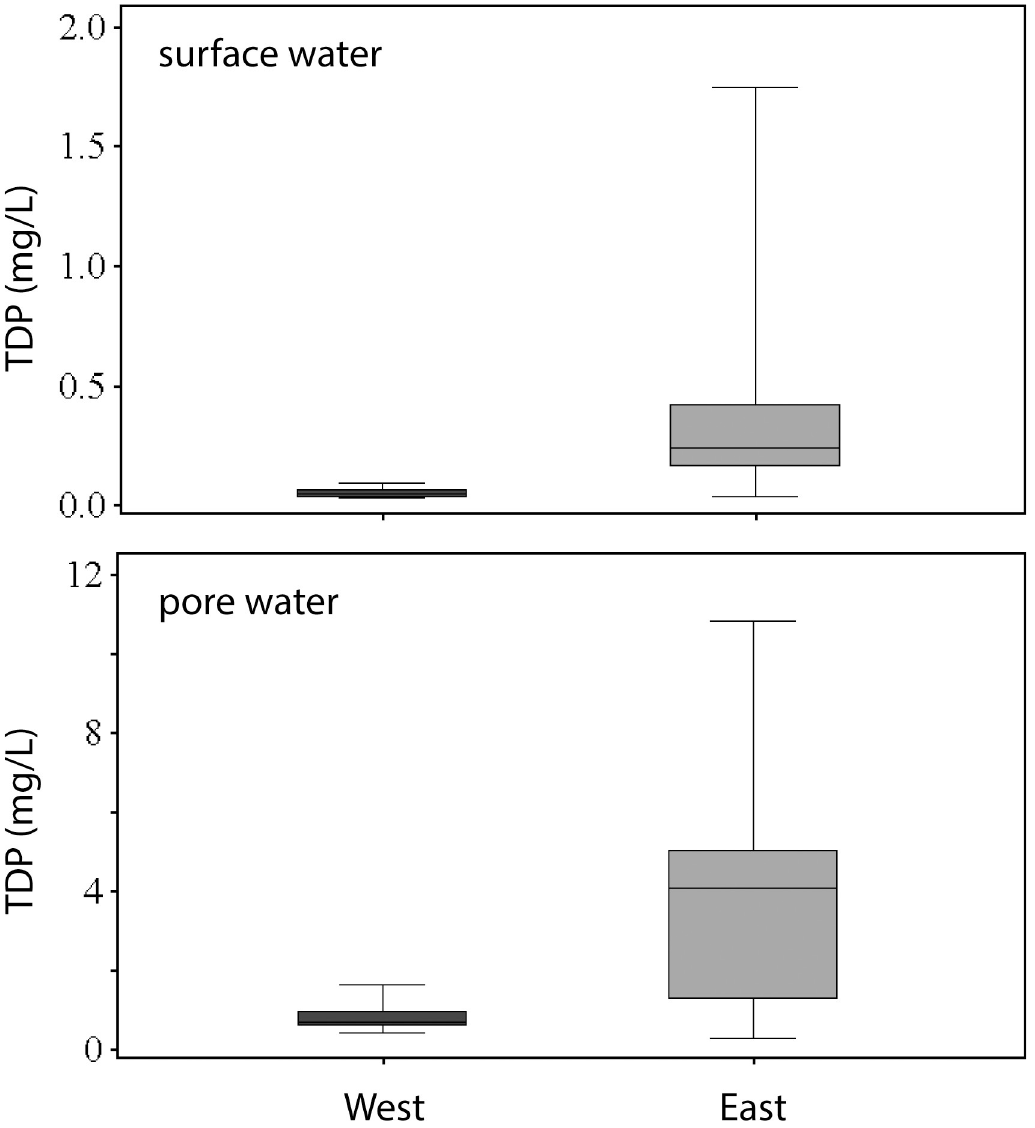
Fig 5. Total dissolved phosphorus (TDP) concentrations in surface water (top) and pore water (bottom). West samples ( n = 13) were collected from sites 2–3, 5–10, and 14. East samples ( n = 13) were collected from sites 1, 4, 11–13, and 15. For each sample type, TDP concentrations were averaged from the four sampling